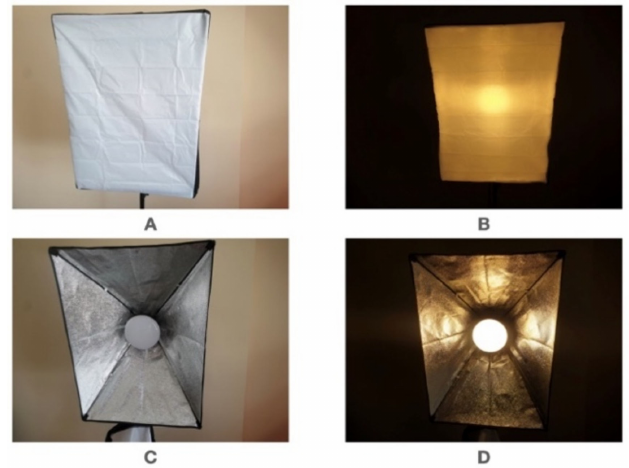
Figure 11. ( A ) Light source with diffuser when light off. ( B ) Light source with diffuser when light on. ( C ) Light source without diffuser when light off. ( D ) Light source without diffuser when light on. The controlled light direction was aimed at the backside of the drone’s camera; thus, the sensor (Lux) was moved to the backside of the drone, as shown in Figure 12.